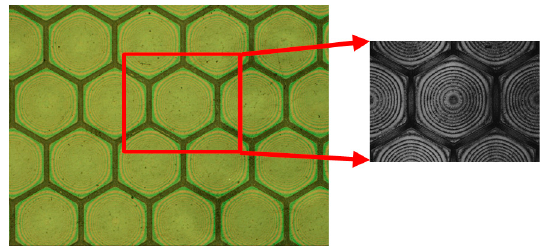
Figure 14. Newton’s rings on the membranes increase in number after 24 h of operation.